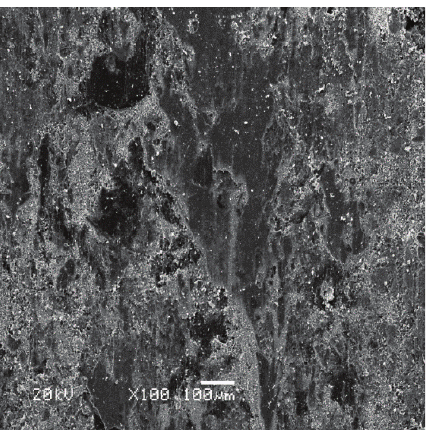
Figure 4: SEM picture of surface fully covered with the lubricating film.